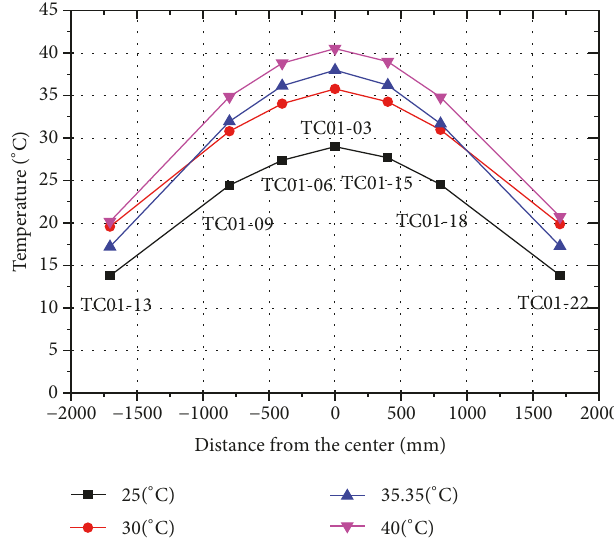
Figure 14: The effect of inlet cooling air temperature on support bottom.